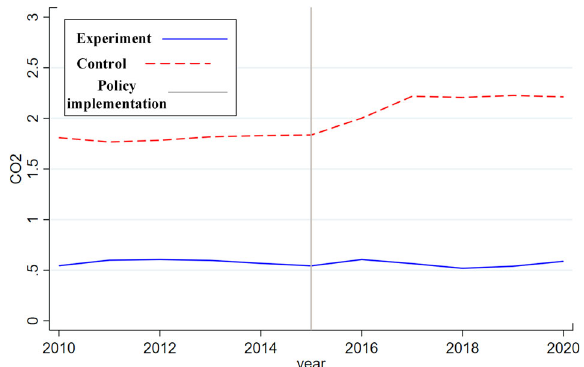
Fig. 4 In fl uence of the B&R policy on the GD level of construction enterprises — parallel trend test. The control group (red dashed line) and the cut-off line for the B&R policy implementation year (grey solid line) are